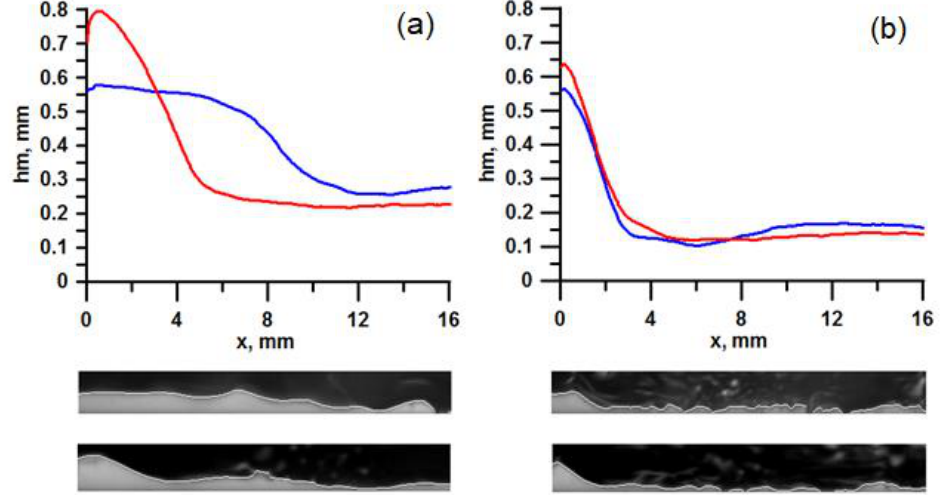
Figure 2. Dependence of the time-averaged film thickness on the downstream coordinate: ( a ) water–glycerol solution (WGS1), Q L = 10.3 mL/s, V G = 22 m/s; ( b ) WGS1, Q L = 10.3 mL/s, V G = 43 m/s.